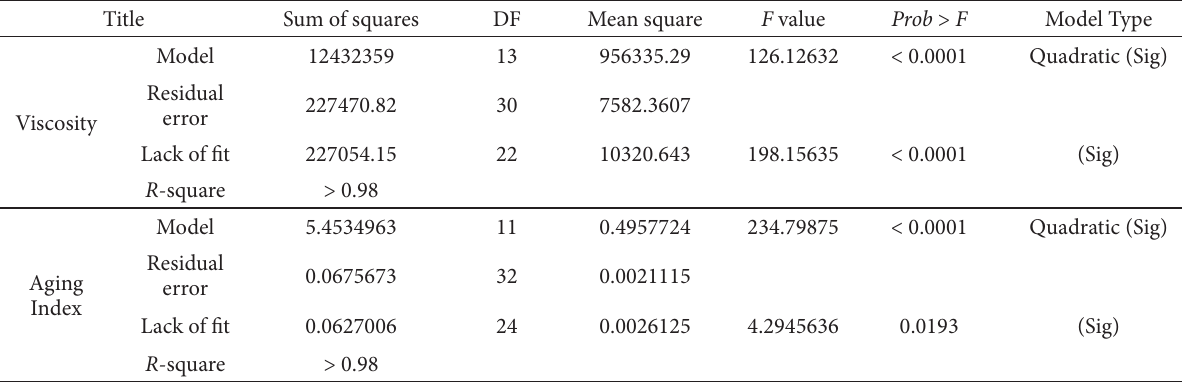
Table 4. Models proposed for viscosity and aging index